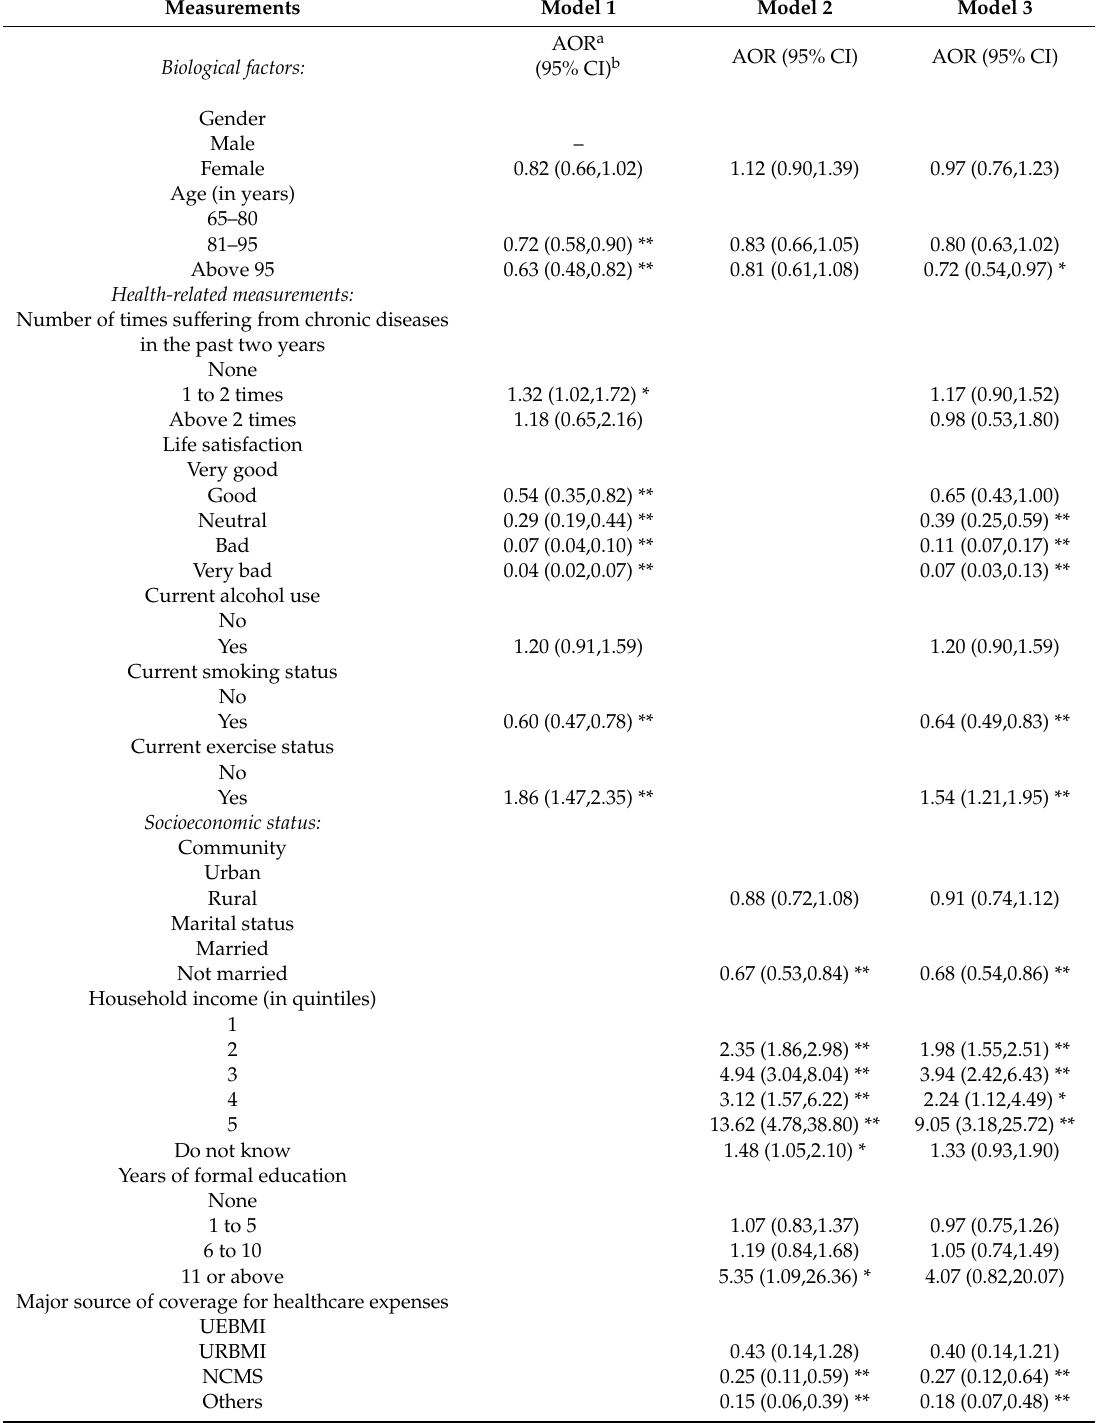
Table 3. Results of Firth’s logistic regressions: Chinese Longitudinal Healthy Longevity Survey (CLHLS),